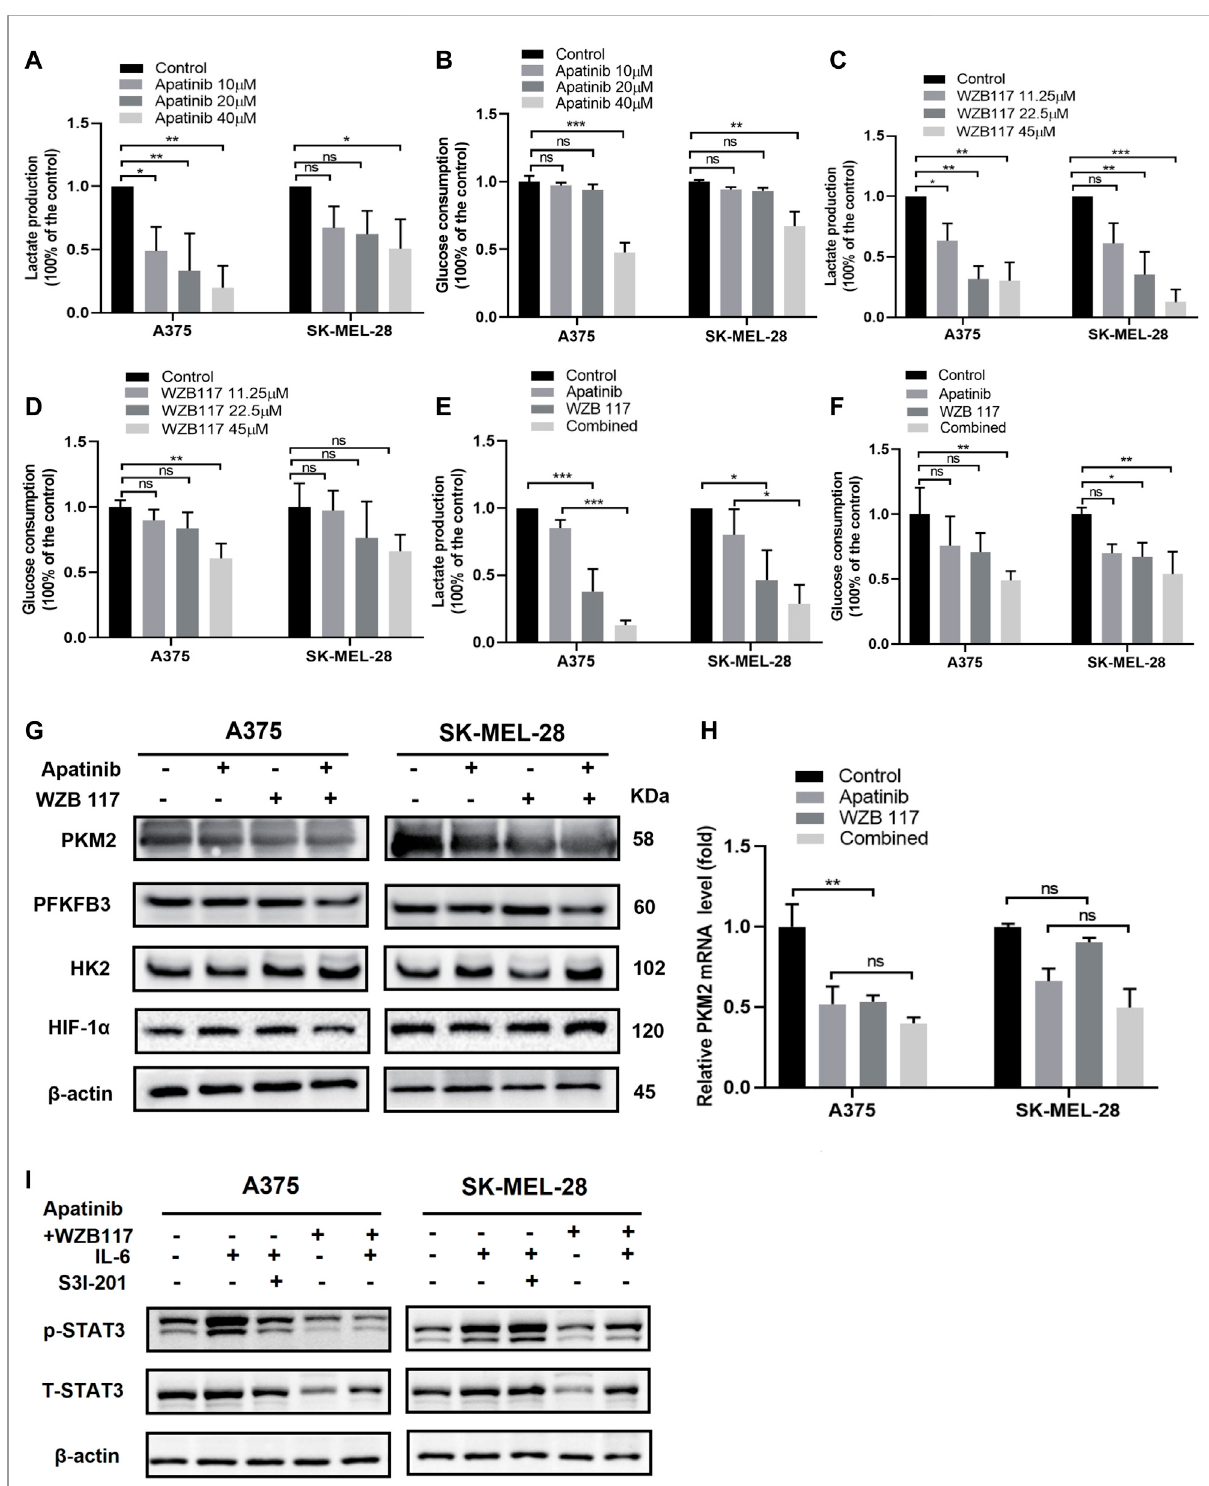
FIGURE 5 Apatinib combined with WZB117 inhibits glycolysis via STAT3 in A375 and SK-MEL-28 cells. (A,B) Lactate production and glucose consumption of both cells after being treated with a range concentration of apatinib for 48 h. Data are presented as the mean ± SD of three independent experiments, except for lactate production assay in A375 cells (N = 4). (C,D) Lactate production and glucose consumption of both cells after being treated with a range concentration of WZB117 for 48 h. Data are presented as the mean ± SD of three independent experiments, except